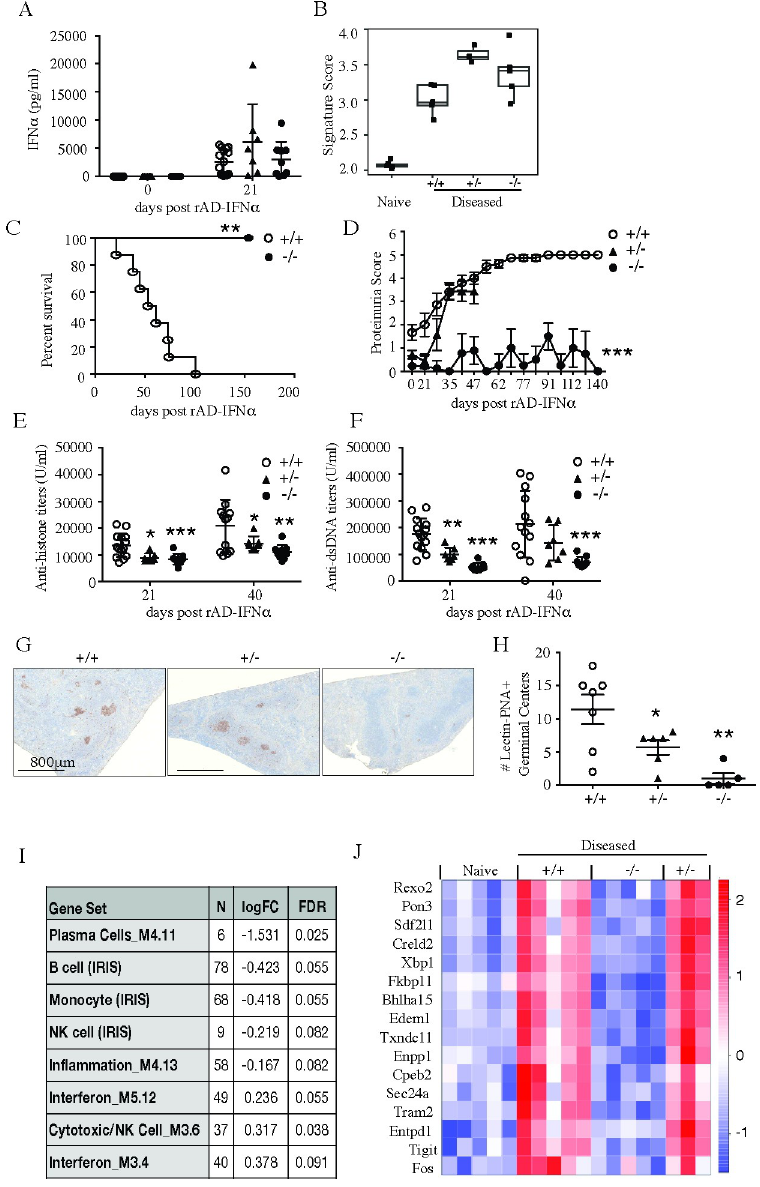
Fig 7. SLC15A4 deficient mice are protected from IFN α accelerated lupus disease development in NZB/W F1 mice. 14–15 week-old NZB/W F1 slc15a4 +/+ , slc15a4 +/- and slc15a4 -/- mice were injected intravenously with 1.2x10 8 pfu IFN α rAd5- IFN α . Three weeks post rAd-IFN α administration, serum IFN α levels were assessed by ELISA (A) and interferon gene signature score was assessed in spleen after 7 weeks (B). Mice were regularly monitored for survival (C) and proteinuria (D) rAd-IFN α administration. Serum anti-histone antibody (E) and anti-dsDNA antibody (F) titers were assessed by ELISA 3 weeks and 6 weeks post rAd-IFN α administration. Data is expressed as mean ± SD and each symbol represents an individual mouse in respective groups. Germinal center formation was assessed by PNA staining in spleen after 7 weeks; representative immunohistochemistry sections (G) and numbers of PNA + germinal centers expressed as mean ± SD (H) are shown. Gene set enrichment analysis was performed using pre-defined immune gene modules after 7 weeks. Gene sets that showed significant enrichment (p < 0.01) are shown with log fold change and FDR (I). Transcripts associated with antibody-secreting cell generation were significantly reduced in the absence of slc15a4 and visualized here as heatmap of select antibody-secreting cell-specific transcripts that were induced with disease (log2-fold change > 2, p < 0.05) (J). Comparisons were made between wildtype group and knockouts or heterozygous groups � p < 0.05, �� p < 0.005, ��� p < 0.0005, N = 5 per group.